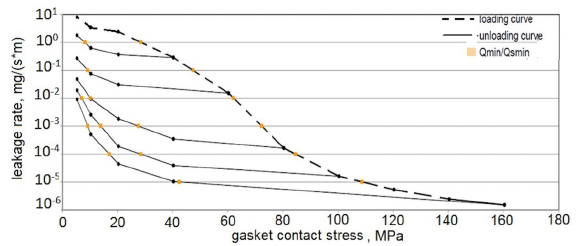
Figure 3: The characteristic describing leakage rate vs applied con- tact stress of the FG_1 gasket